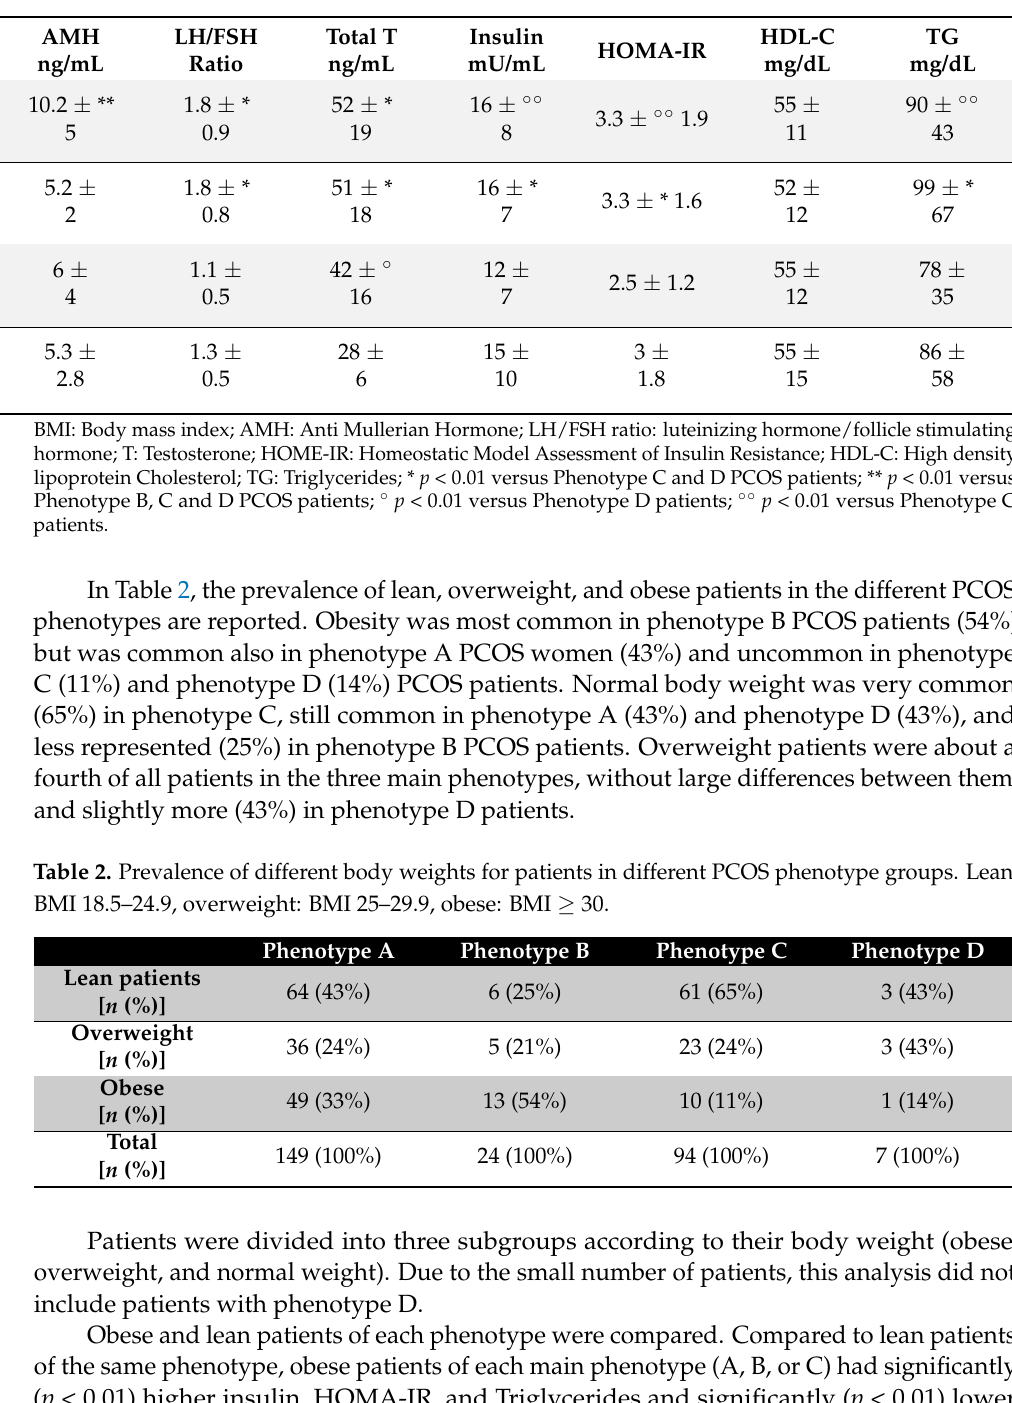
Table 1. Some clinical and hormonal values of 149 Phenotype A, 24 Phenotype B, 94 Phenotype C and 7 Phenotype D patients with Polycystic Ovary Syndrome (PCOS).